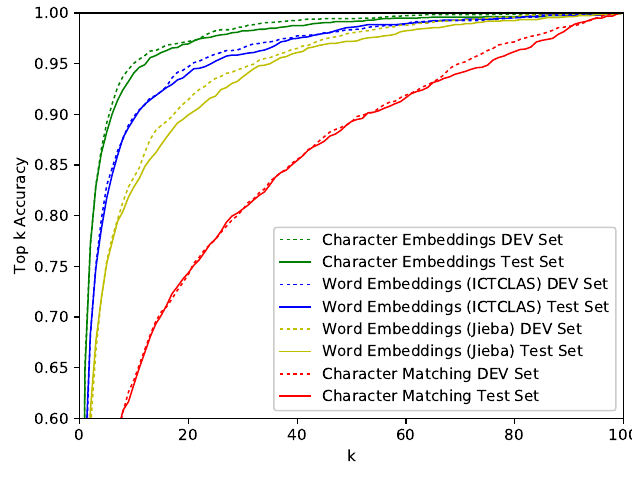
Figure 5. Top-k Accuracy according to